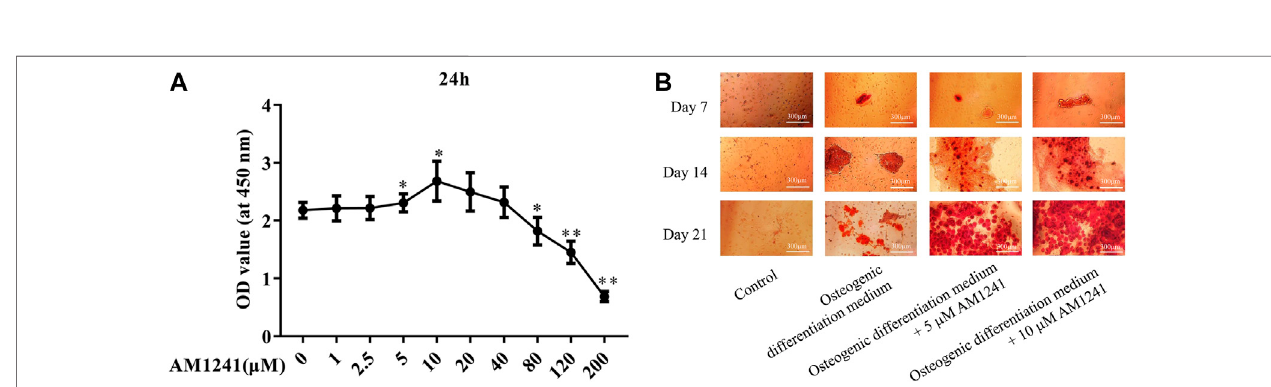
Frontiers in Cell and Developmental Biology |